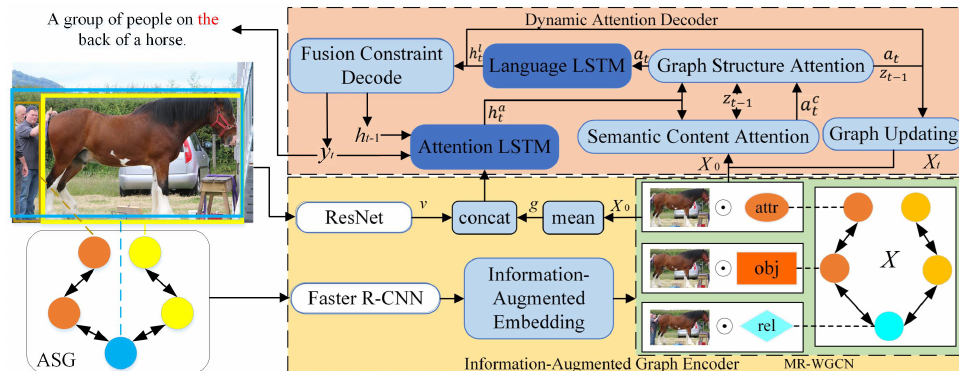
Figure 1. The IANR includes an Information-Augmented Graph Encoder and a Dynamic Attention Decoder. Given an image I and a control signal ASG G = ( X , E ) , X and E are the sets of nodes and edges. The information-augmented embedding adds a priori information to all nodes. The proposed MR-WGCN enhances node features through surrounding information. Then the Dynamic Attention Decoder incorporates the result of Semantic Content Attention and Graph Structure Attention to select node information. Finally, this paper generates sentences through language LSTM and the proposed Fusion Constraint Decode module. After generating a word, we updated the node feature of graph X t − 1 to X t